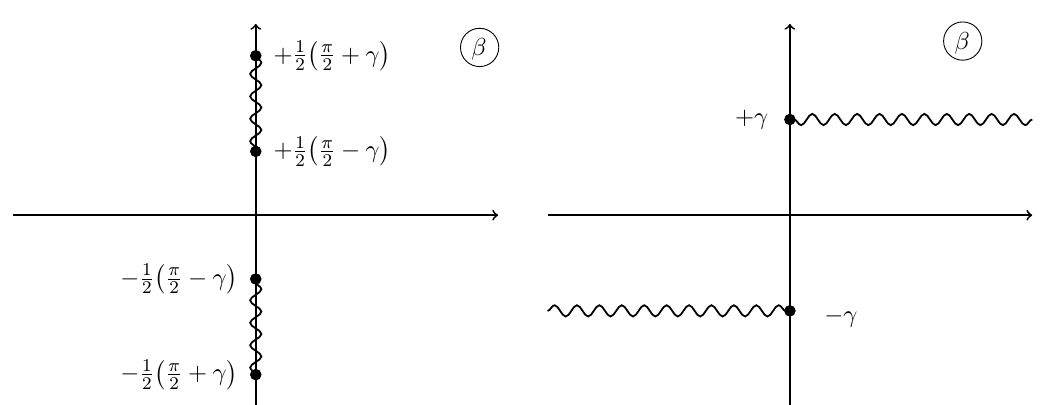
Figure 3. The complex (cid:12) -plane displaying the branch cuts for the functions P (left panel) and (cid:2) (right panel) that are closest to the origin. Subsequent cuts are obtained by shifting this picture by i (cid:25)N with integer N